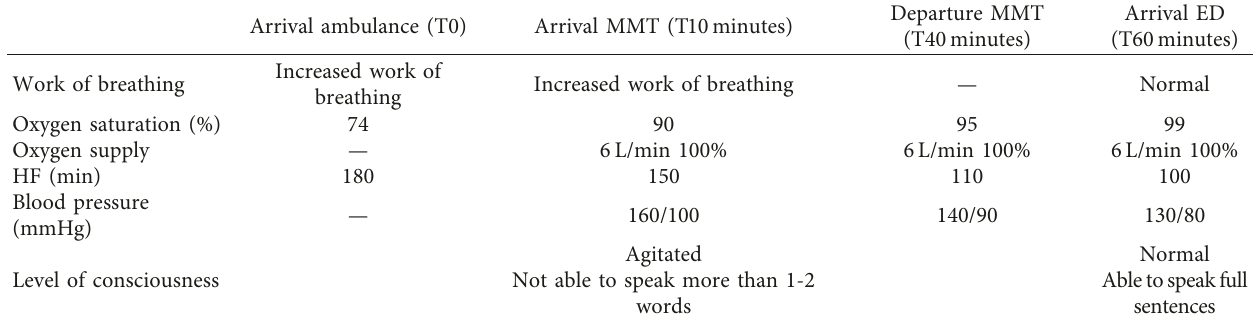
Table 1: Vital parameters.